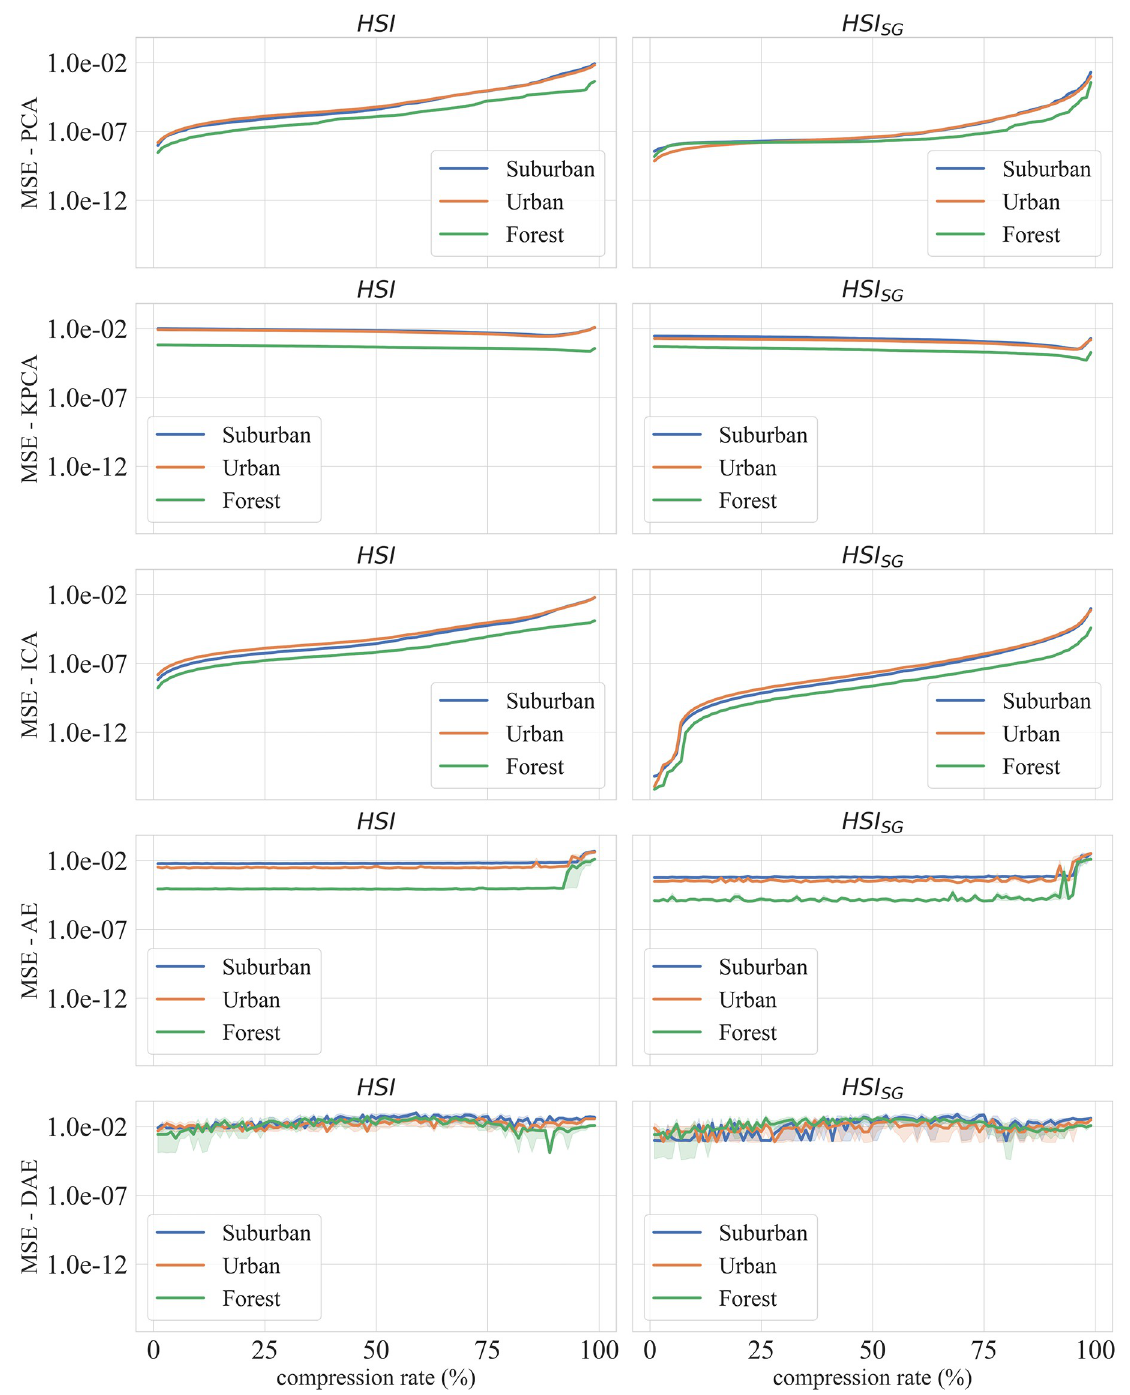
Fig 4. MSE (Mean Squared Error) for the 3 datasets and 5 compression algorithms, from top to bottom: a) Principal Component Analysis, b) Independent Component Analysis, c) Kernel Principal Component Analysis, d) AutoEncoder, e) Denoising